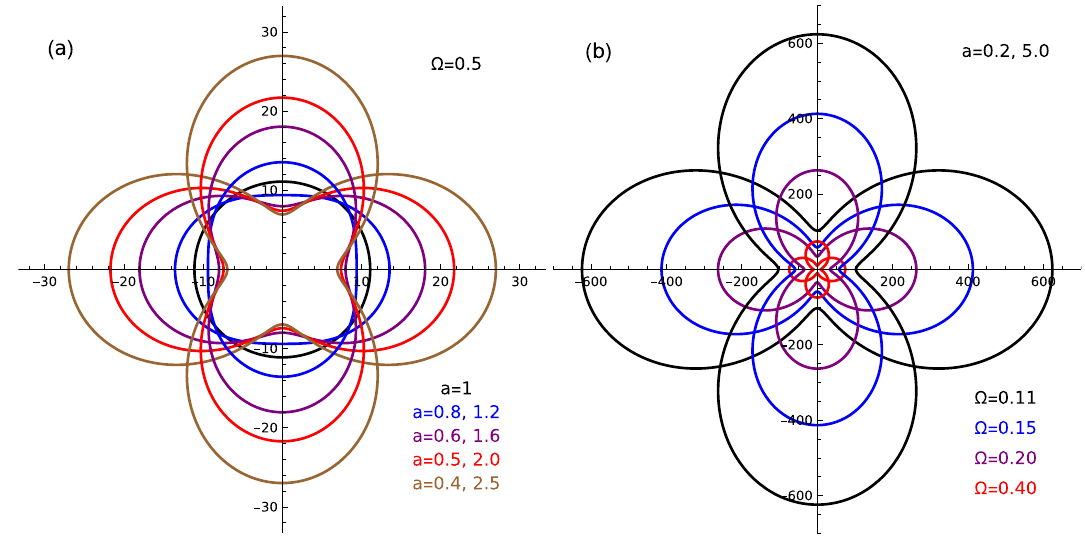
Figure 3. Ground state static dipole polarizabilities of Mott-Wannier excitons for different levels of anisotropy of confinement: ( a ) dependence on anisotropy parameter a = ω x /ω y with fixed confining strength (cid:31) = 0.5 ; left (right) column listing anisotropy parameters a corresponds to the deformation along x (y) axis; ( b ) dependence on confining strength (cid:31) with fixed anisotropy parameter a = ω x /ω y = 0.2 (deformation along x axis) and a = ω x /ω y = 5 (deformation along y axis). Material parameters of MoS 2 monolayer has been used: µ = 0.28 in units of free electron mass and ε = 5 . In the case of unconfined system ( (cid:31) = 0 ) polarizability is given by α(� = 0, µ , ε) = µ − 3 ε 4 α 2 D , where α 2 D = 21 / 128 is the polarizability of ideal 2D hydrogen atom. The value of polarizability for any direction is equal to the distance of the point on the curve from origin. Polarizabilities are given in units of a 3 0 , where a 0 ≃ 0.529Å is the Bohr